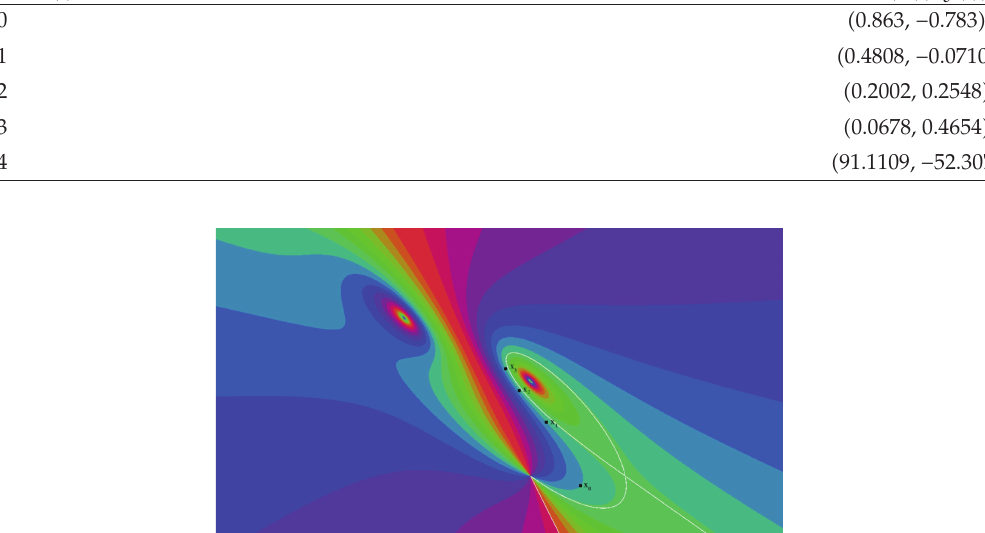
(cid:2) h 2 (cid:3) x,y (cid:4) (cid:5) 2 . 26841 − t for